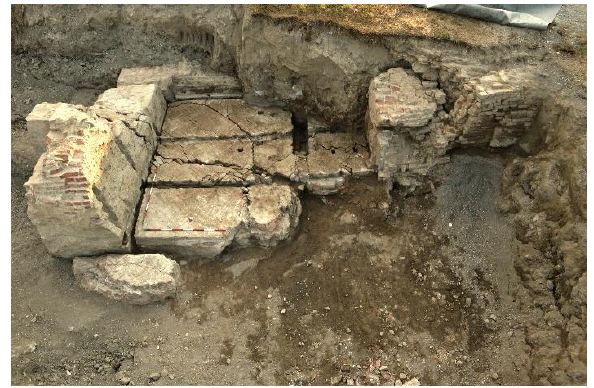
Figure 4. The remains of the watermill: details of the mill-pond and channels for the functioning of the